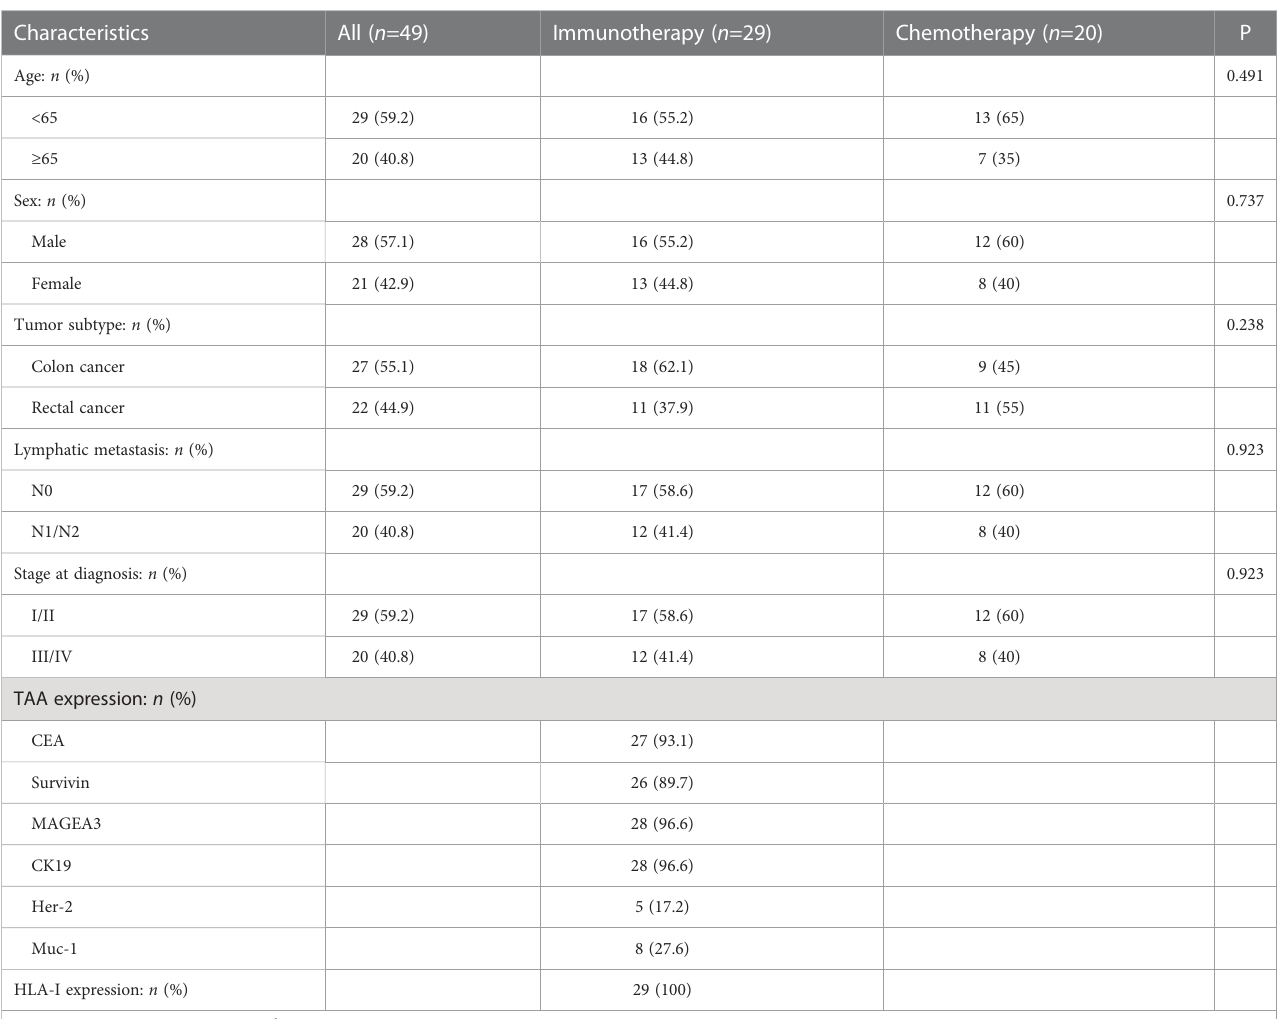
TABLE 1 Baseline characteristics.